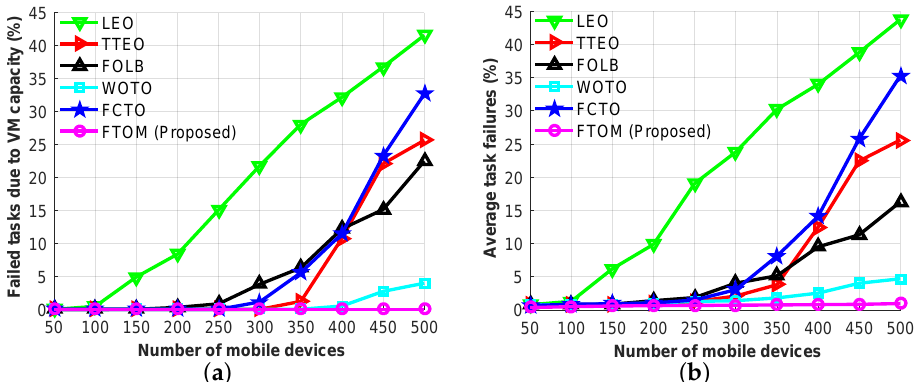
Figure 12. Performance analysis based on each application type: ( a ) failed tasks due to VM capacity; ( b ) average task failure rate.